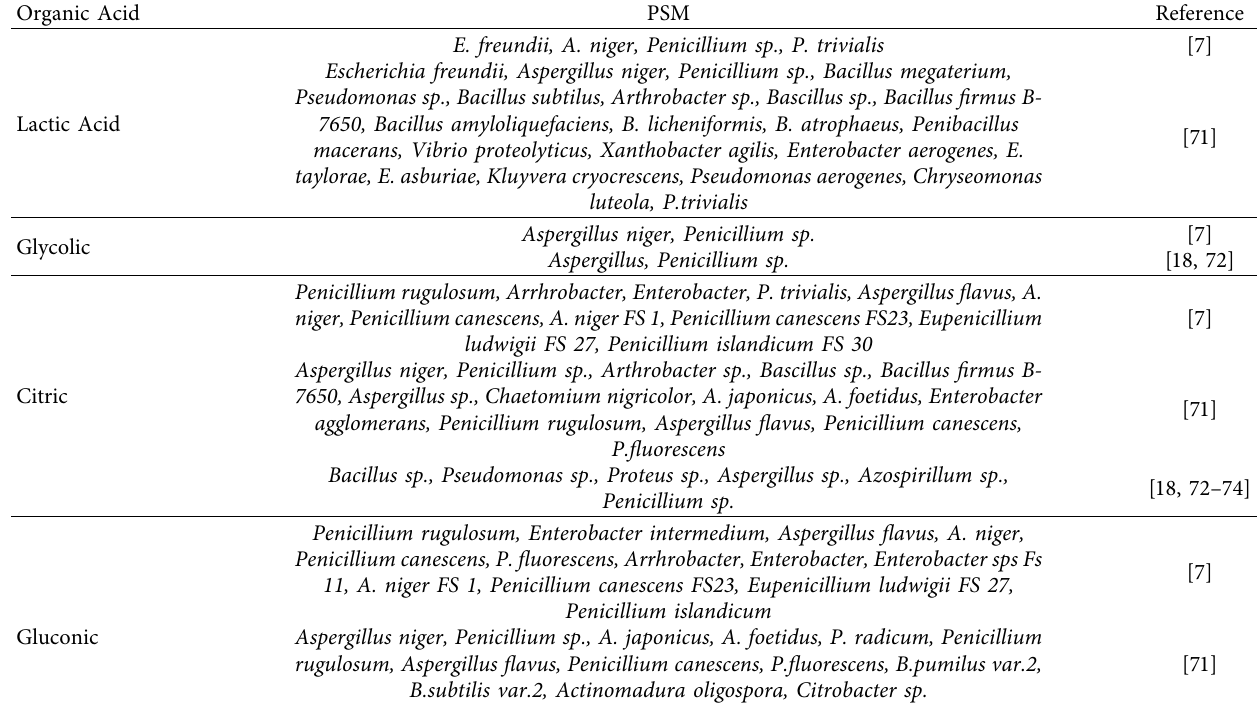
Table 3: Organic acid secreting